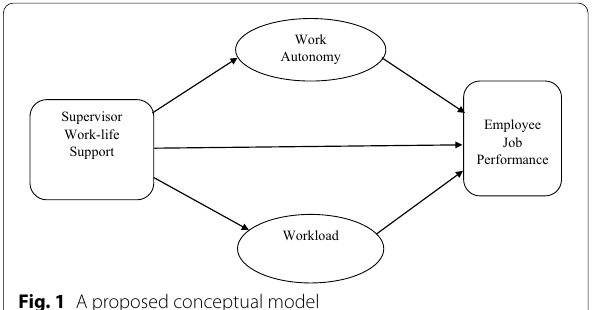
Fig. 1 A proposed conceptual